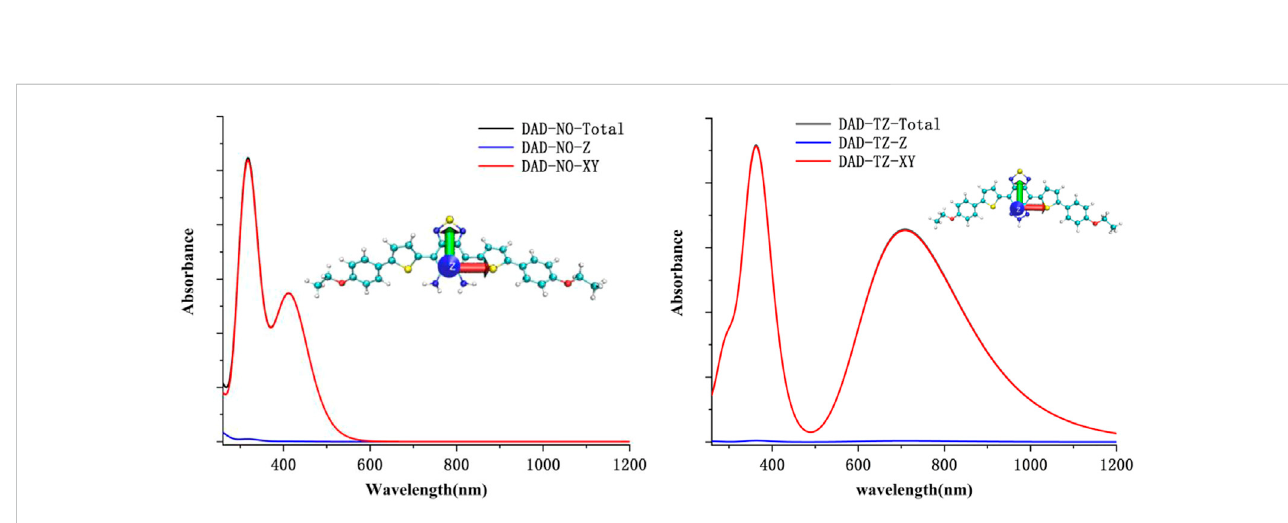
Calculated UV-Vis spectrum of DAD-NO and DAD-TZ in aqueous